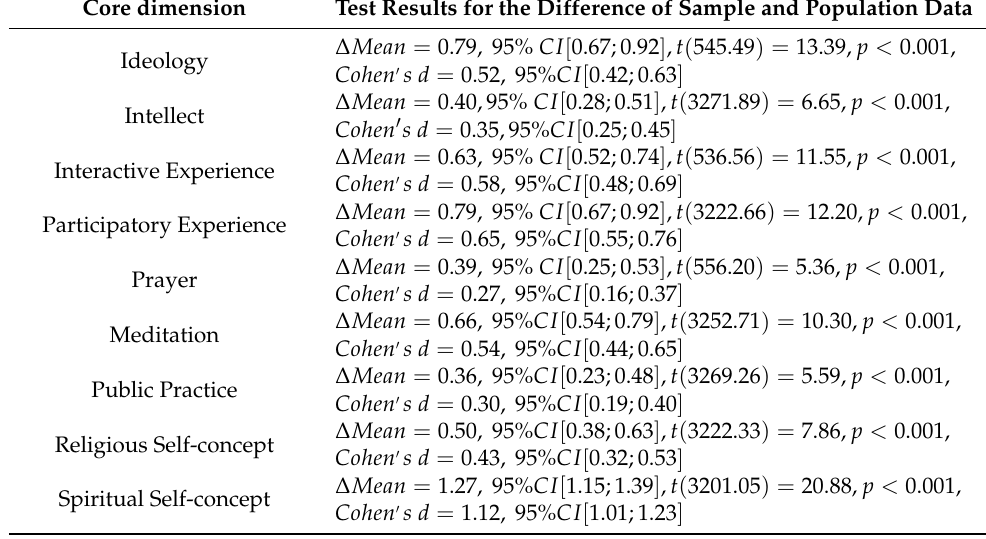
Table A1. t -tests of the mean differences between the pilgrim sample and the weighted sample of German speakers from Germany, Austria, and Switzerland. Core dimension Test Results for the Difference of Sample and Population Data